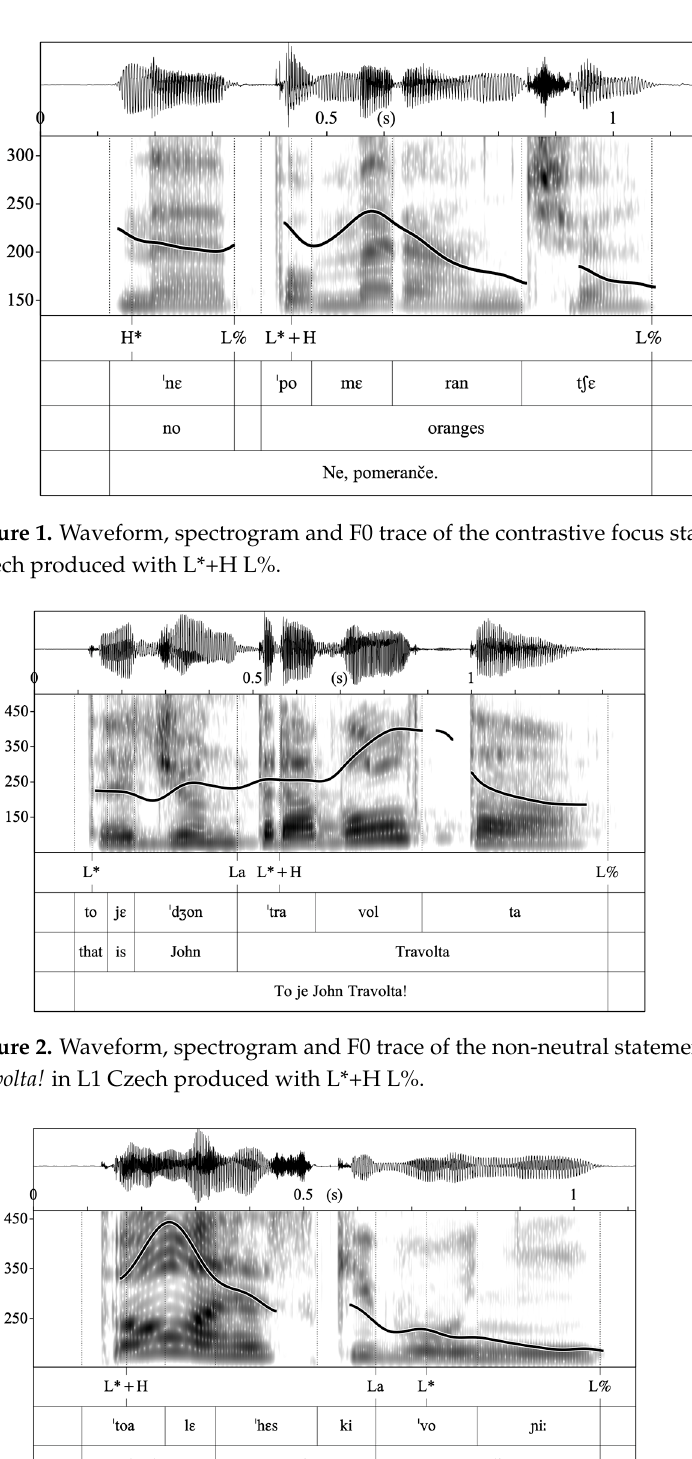
Figure 3. Waveform, spectrogram and F0 trace of the what -exclamative statement What a lovely smell! in L1 Czech produced with L* L%.